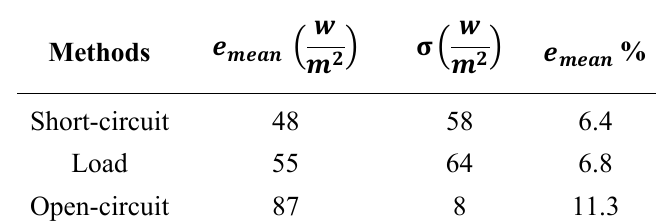
Table 2. Statistical analysis for all estimation methods: Mean error, standard deviation and percentage error of the solar radiation vs. G meas